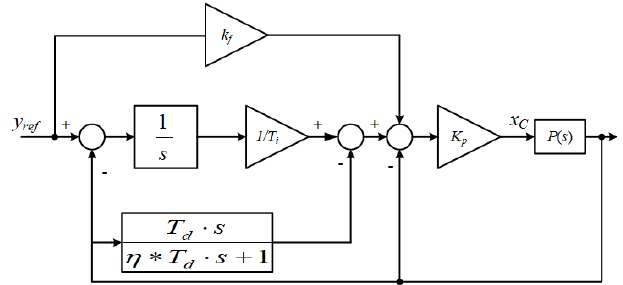
Figure 3. Structure of conventional I-PD